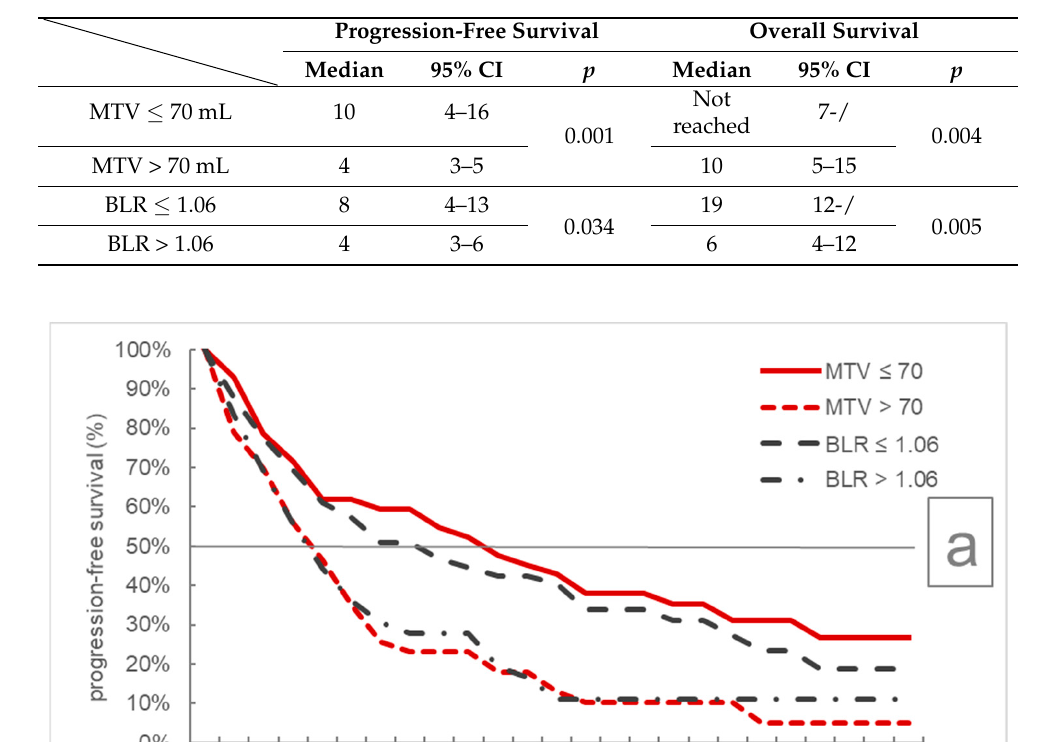
Table 3. Radiological best response and disease control rate according to RECIST. RECIST = Response Evaluation Criteria in Solid Tumors, CR = complete remission, PR = partial remission, SD = stable disease, PD = progressive disease, MTV = metabolic tumor volume, BLR = bone marrow to liver ratio.